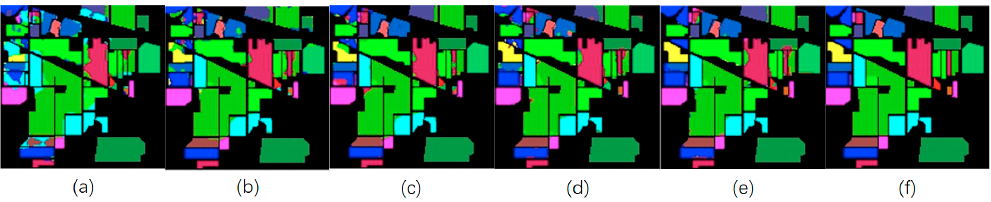
Figure 2. The predicted classification maps for 5% samples from the Indian Pine dataset with the method of ( a ) 2D-CNN, ( b ) M3D-CNN, ( c ) HybridSN, ( d ) R-HybridSN, and ( e ) MSPN and ( f ) ground truth.